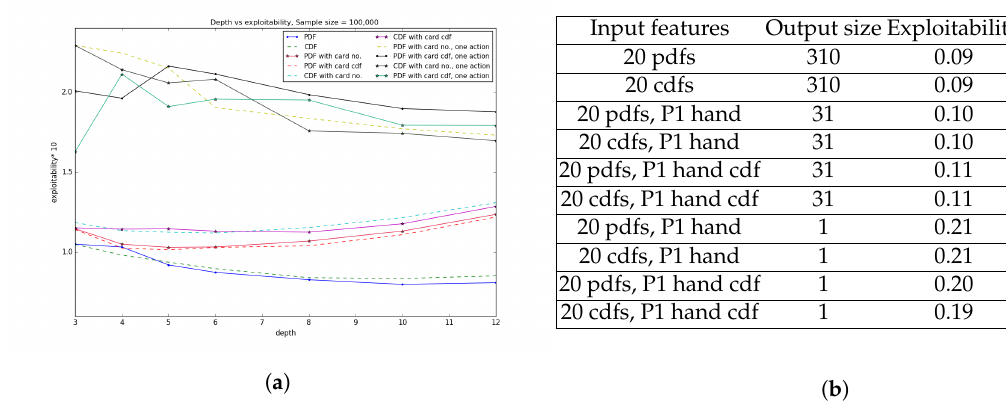
Figure 6. Exploitability vs. decision-tree depth (Figure 6a). Performance for depth-5 tree (Figure